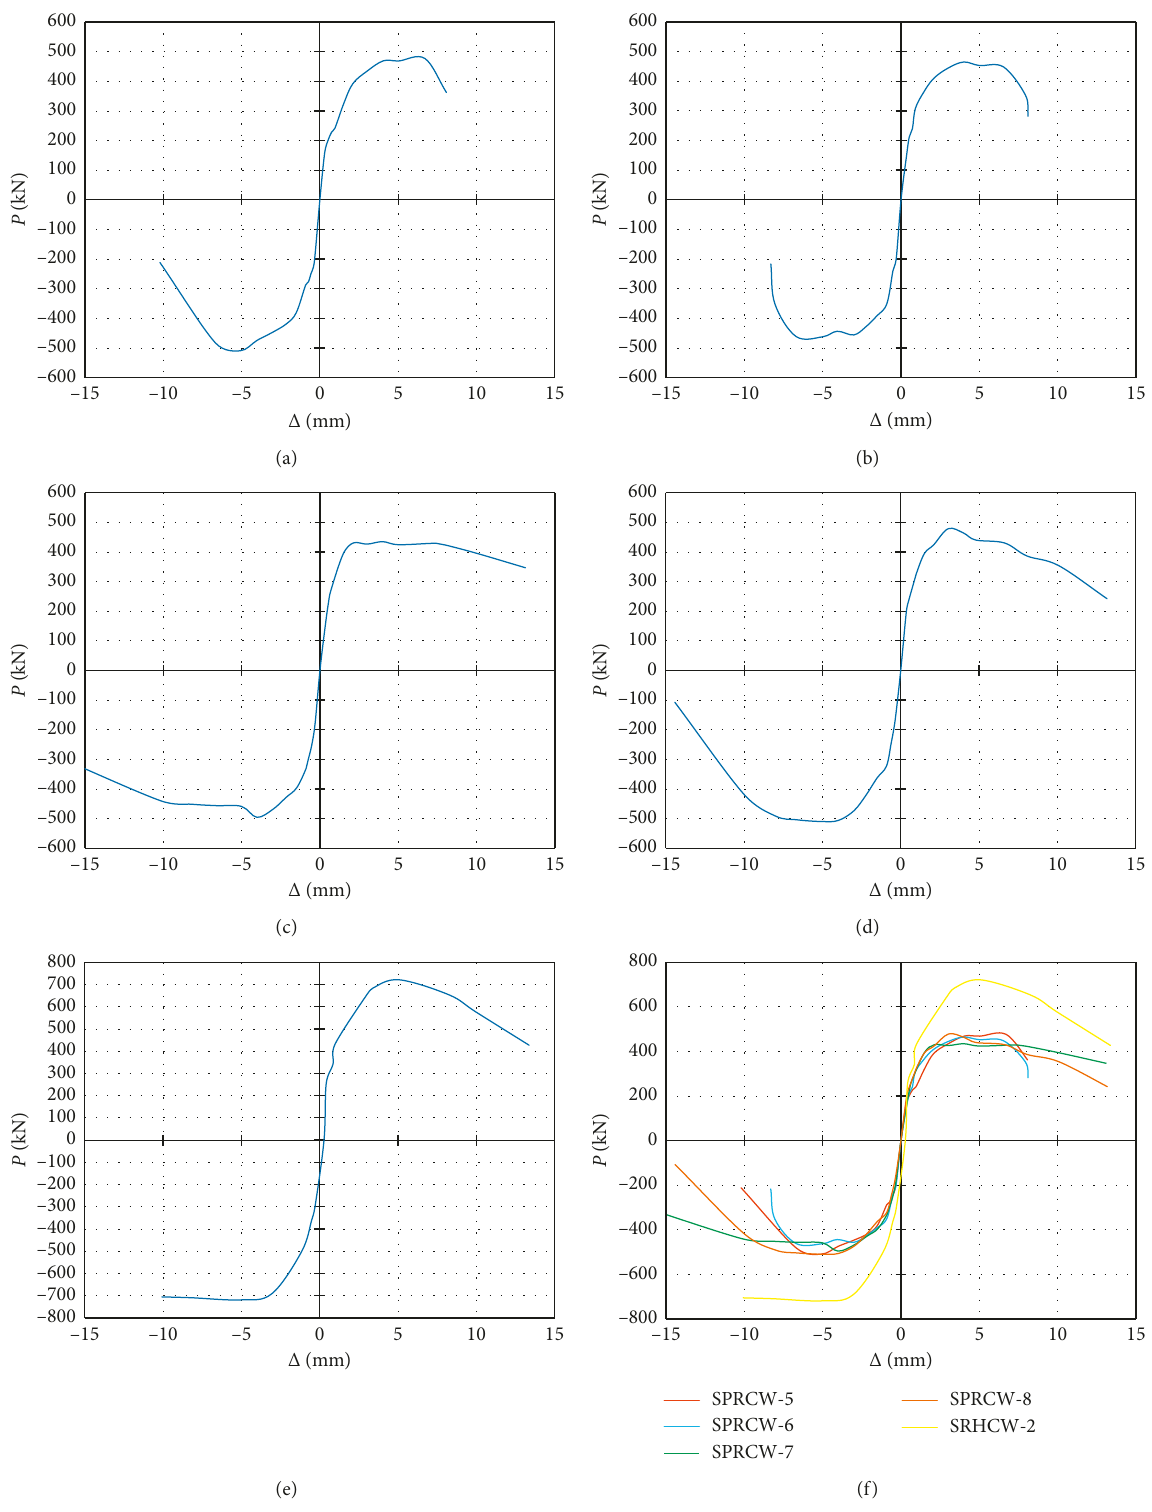
Figure 12: Skeleton curves of shear wall test pieces. (a) Skeleton curve of SPRCW-5. (b) Skeleton curve of SPRCW-6. (c) Skeleton curve of SPRCW-7. (d) Skeleton curve of SPRCW-8. (e) Skeleton curve of SRHCW-2. (f) Skeleton curves of all test